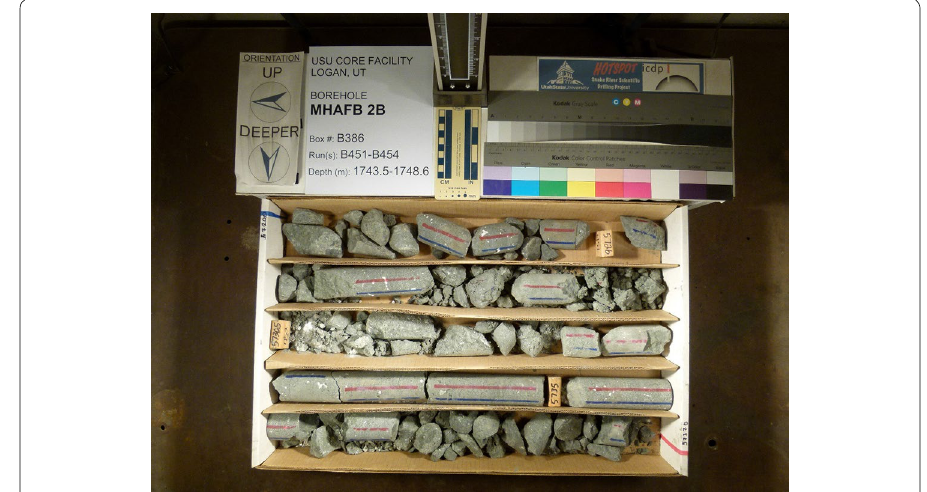
Fig. 5 Core from 1743.5 to 1748.6 m